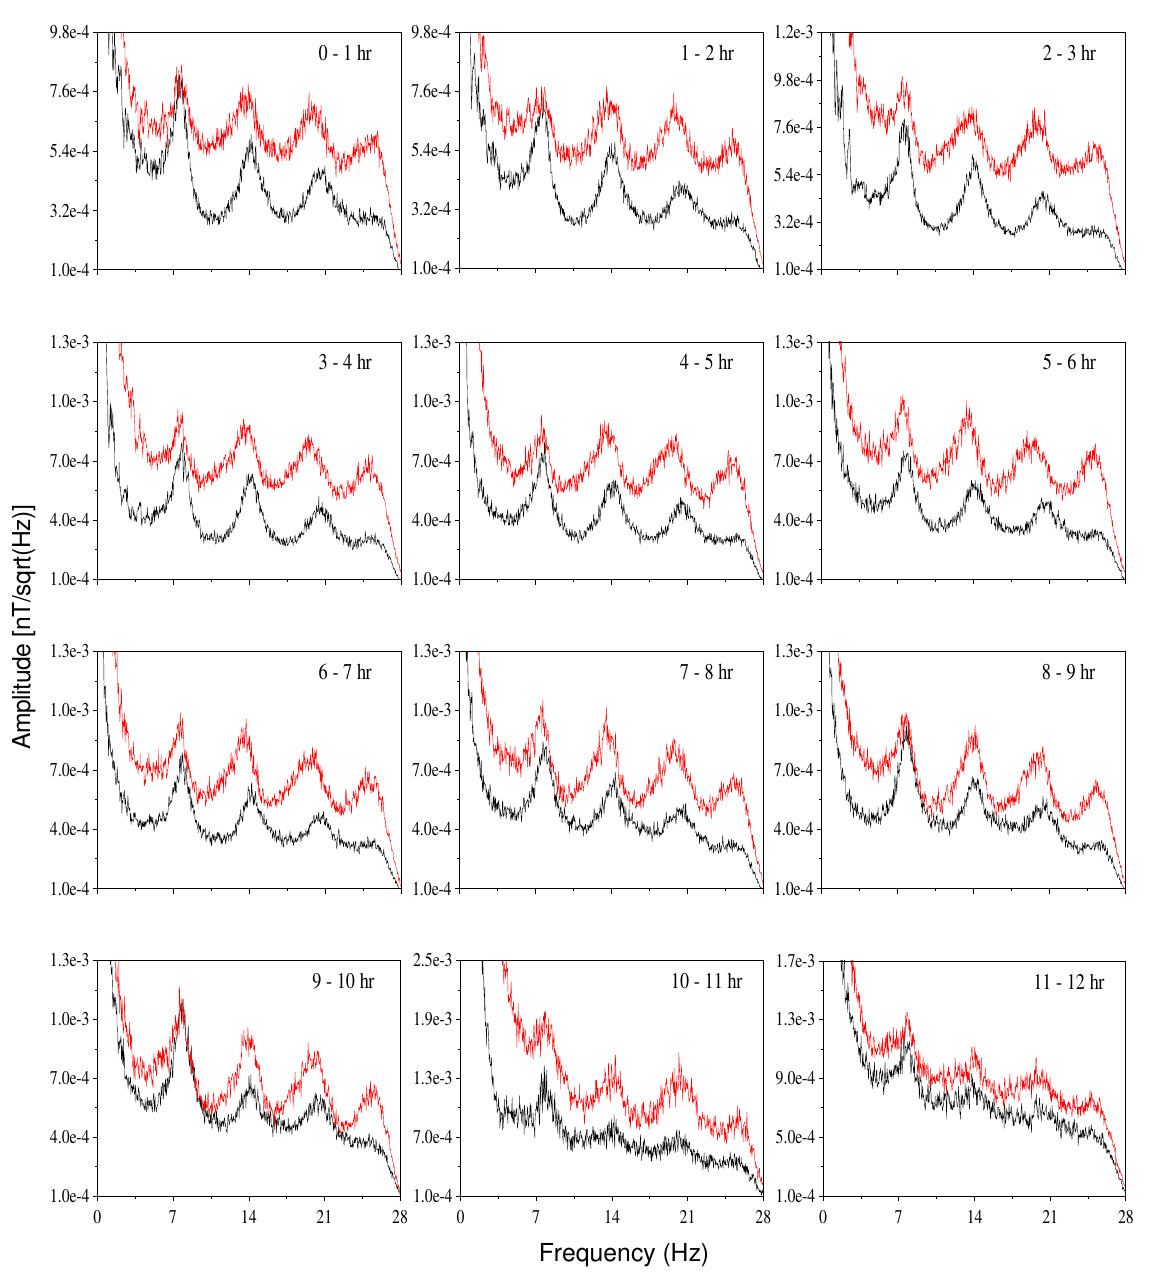
Fig. 1. The hourly variation in amplitude-frequency spectrum of two magnetic field components ( H x and H y ), from the Garhwal Himalayan region recorded at Dharali (lat. 31:02:22.42; long. 78:47:56.37) on 18 May 2006. H x and H y components are shown in black and red,